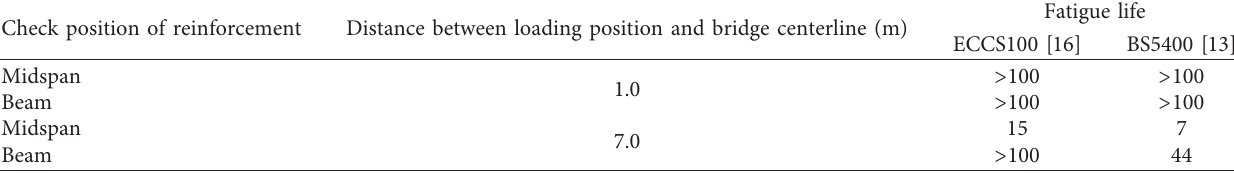
Table 6: Fatigue life of reinforcement bars.